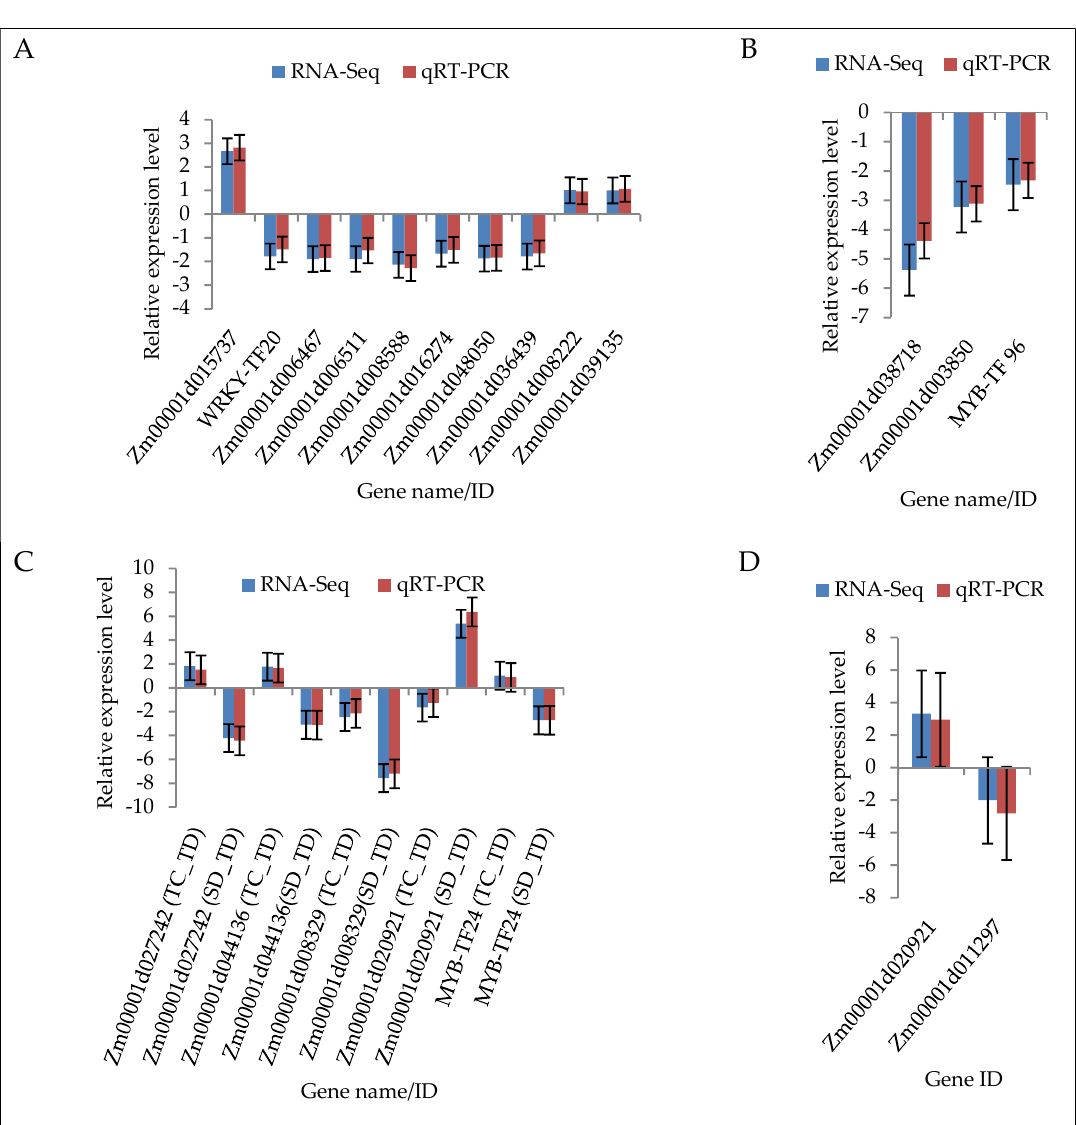
Figure 6. qRT-PCR validation of the RNA-seq data of the 20 randomly selected maize seedling leaf differentially expressed genes (DEGs). ( A ) TC_TD specific DEGs; ( B ) SD_TD specific DEGs; ( C ) DEGs shared between TC_TD and SD_TD; and ( D ) DEGs specific to SC_SD. The y -axis represents the gene relative expression levels (fold changes) in the real-time PCR analysis and fold changes in the RNA-seq data. All the genes with negative values of expression level means that they were down-regulated in response to drought stress. Maize gene GAPDH (accession no. X07156) was used as the internal reference. Error bars represent the SE ( n = 3).